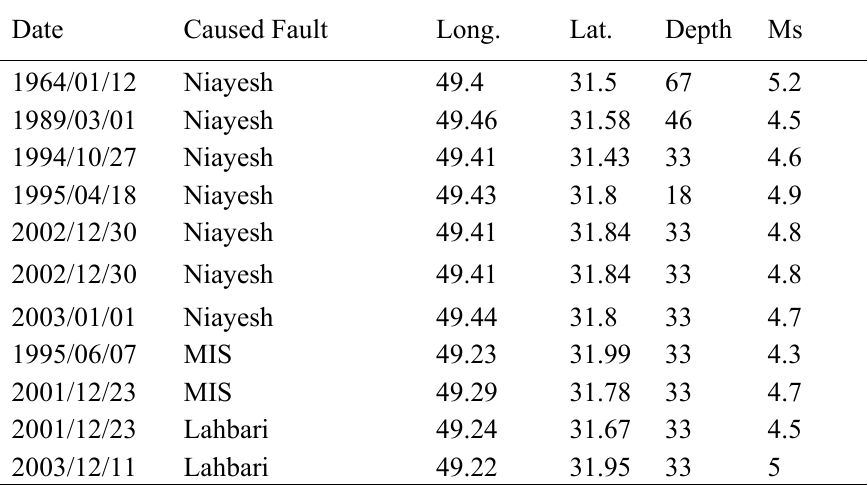
Table 1. The correlation of main quaternary fault zones and earthquakes. Ms = maximum magnitude on the Richter